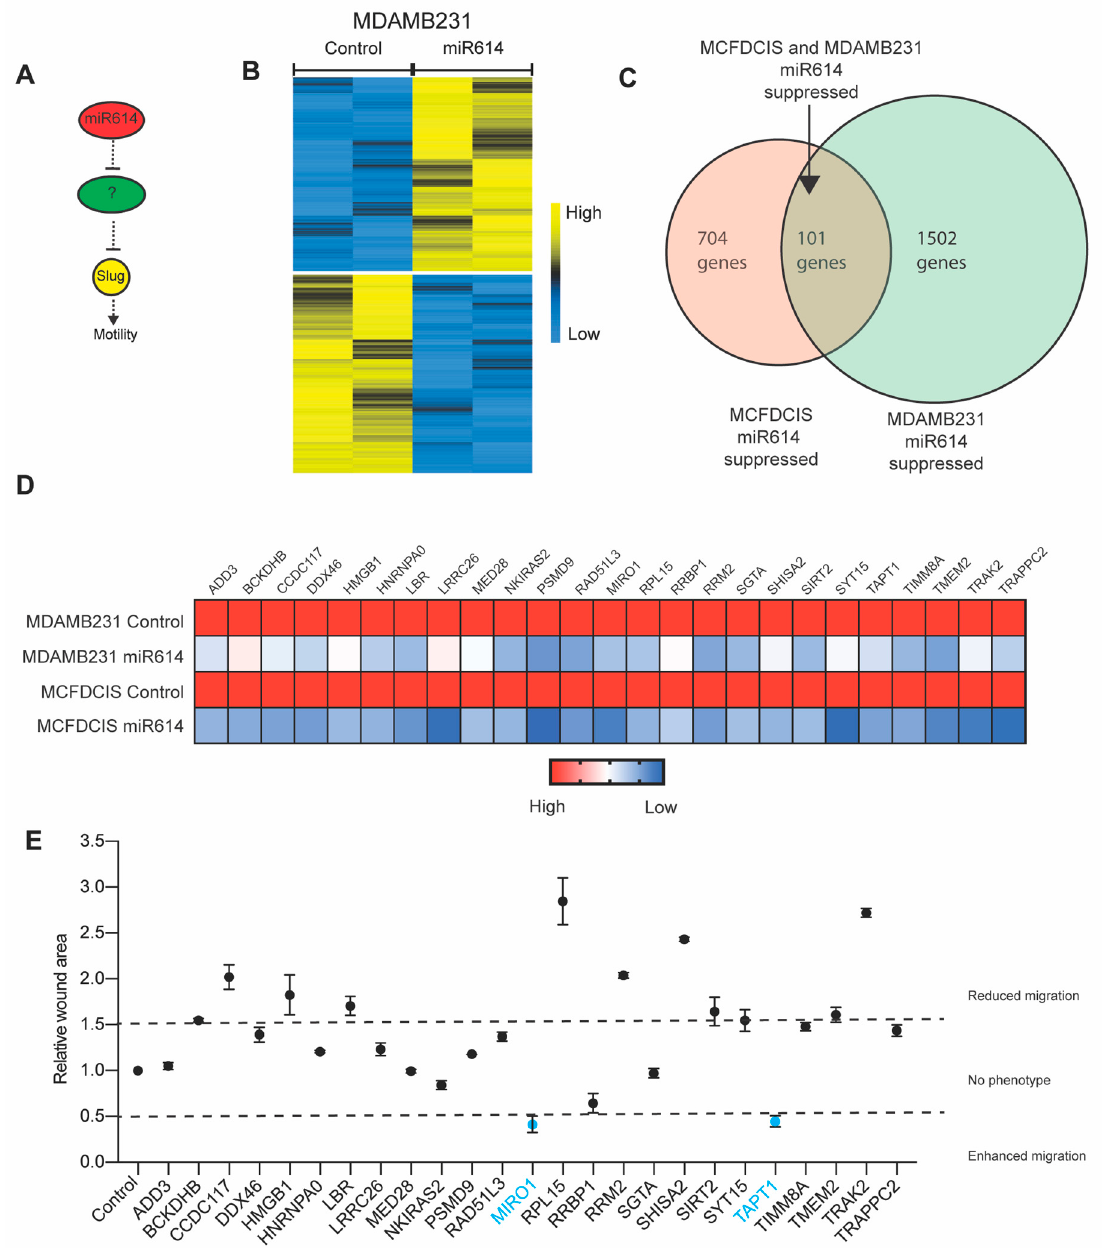
Figure 3. Defining genes suppressed by miR614 that restrict cell migration. ( A ) Model showing that miR614 indirectly regulates the expression of Slug and cell motility through the suppression of gene expression. ( B ) Heatmap showing how miR614 alters gene expression in MDAMB231 cells. Biological replicates are shown. Yellow indicates increased expression and blue indicates reduced expression. ( C ) Venn diagram showing how miR614 suppresses a common set of genes in MCFDCIS and MDAMB231 cells. ( D ) Heatmap showing the suppression of 27 genes by miR614 in MCFDCIS and MDAMB231 cells. All genes had a minimum probe value of 50 when analyzed by microarray. ( E ) Graph showing the results of a screen in which the wound area of MCFDCIS cells transfected with siRNAs targeting the 27 miR614 suppressed genes shown in (D) was determined. The mean (solid circles) ± SD of 3 wells for each condition tested is shown. Dashed lines indicate the threshold for a 50% change in wound closure. The results of siRNAs for targeting Miro1 and TAPT1 are indicated in blue and were prioritized for further investigation.